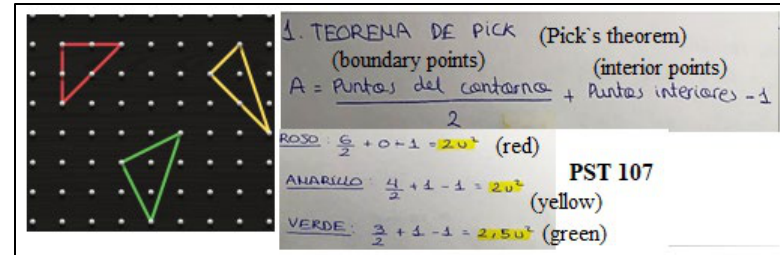
Figure 9. Resolution of PST 107 to Task 4.